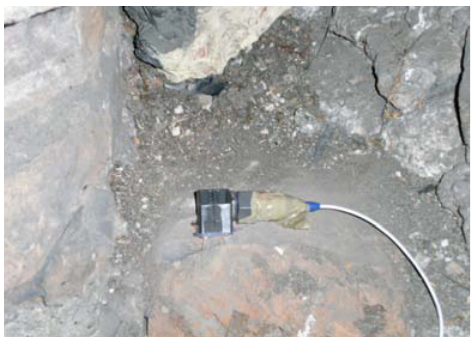
Fig. 5. Accelerometer in the working